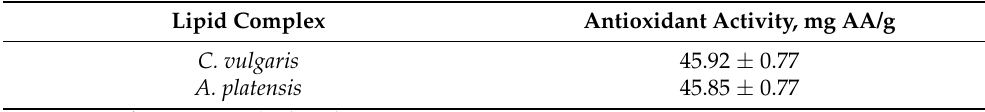
Table 6. Antioxidant activity of lipid complex samples obtained from the microscopic algae biomass. Lipid